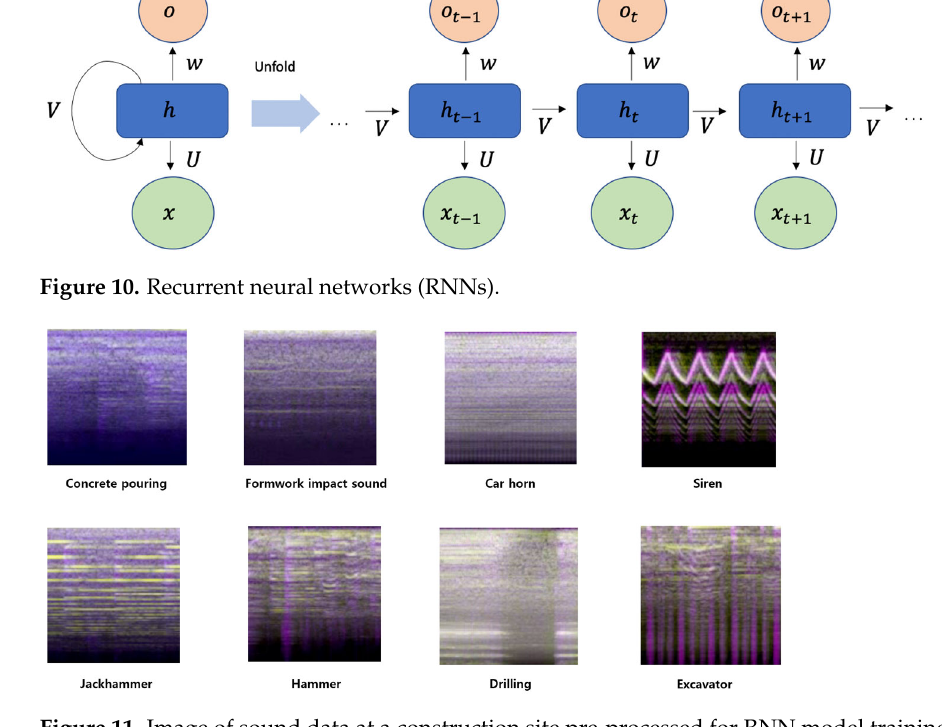
Figure 11. Image of sound data at a construction site pre-processed for RNN model training.